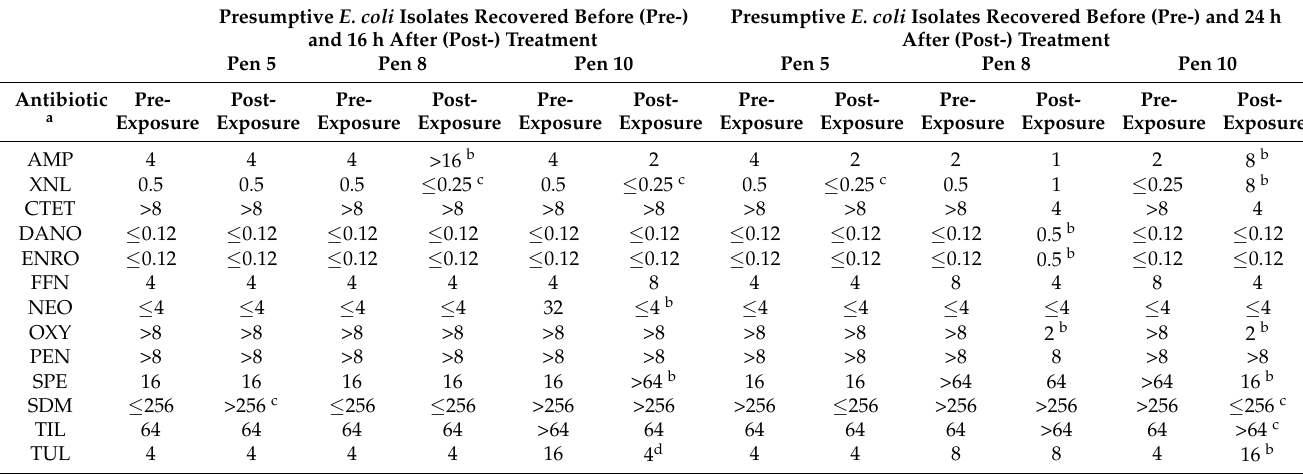
Table 4. Antimicrobial susceptibilities of presumptive E. coli isolated from rectal swabs of pigs before or after feed administration of 54 mg of thymol- β - D -glucopyranoside/kg body weight.